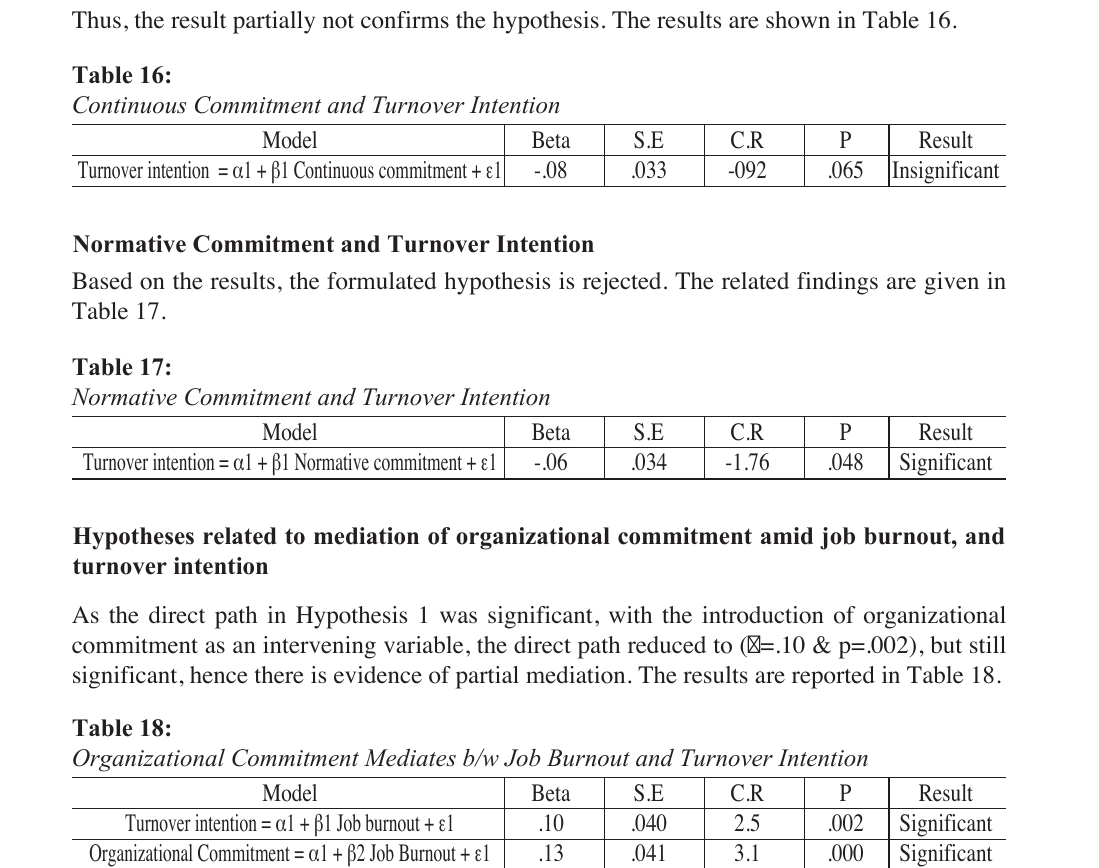
Continuous Commitment and Turnover Intention